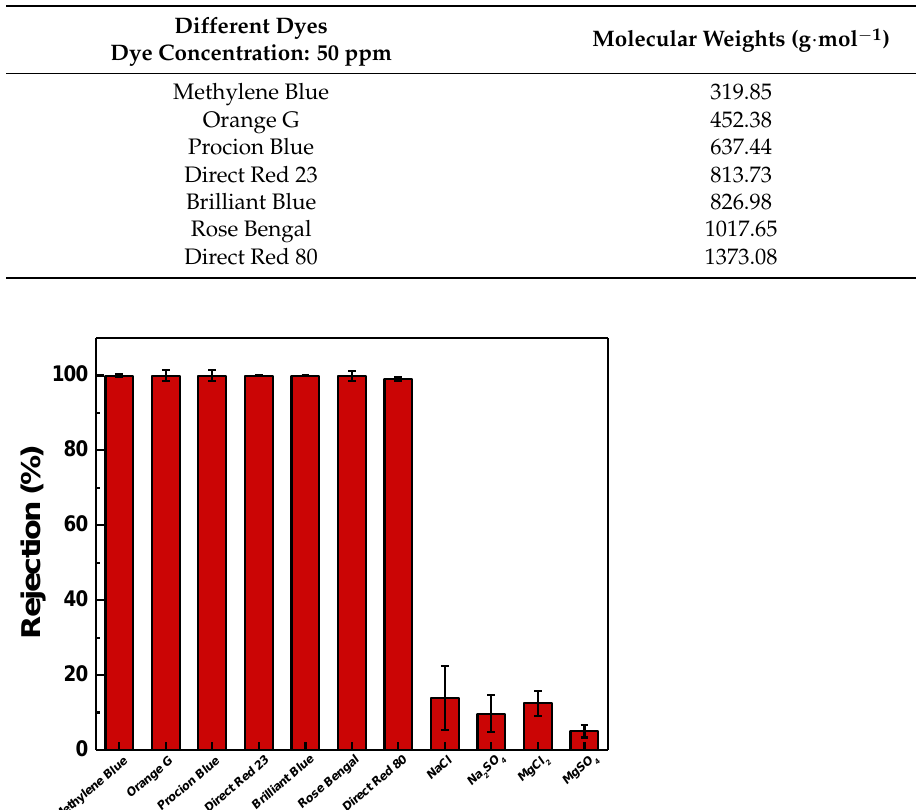
Table 4. Performance comparison of PES mixed matrix membrane of this study and other literature.